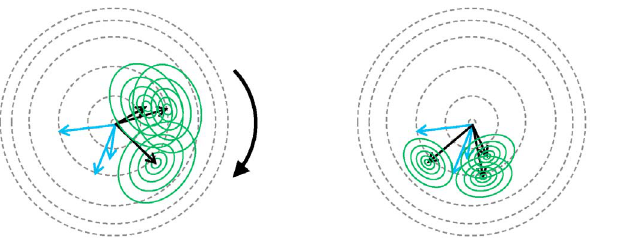
Figure 5. Illustration of the expectation maximization algorithm for periodic variables. The dashed circles illustrate the unit sphere. Arrows indicate the orientation unit vectors projected onto the plane (blue: ~ x , black: ~ y ). The green circles depict values of the Fisher-Mises distribution with centers located at the arrow tips. In the M-step, a rotation around the center is computed that moves the arrow tips closer. Simultaneously, the concentration parameter k is updated and the width of the Fisher-Mises distribution is reduced. Left: before M- step. Right: after M-step.